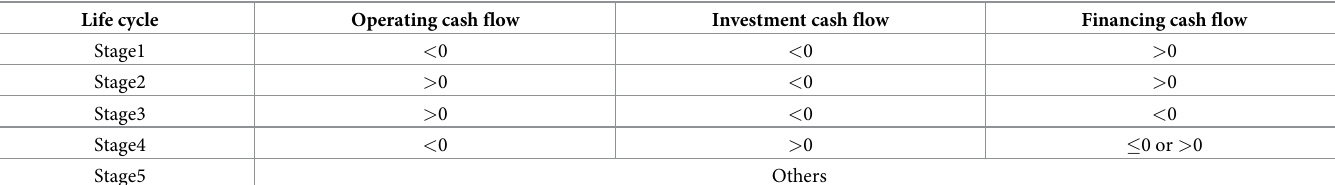
Table 9. Division of enterprise life cycle.